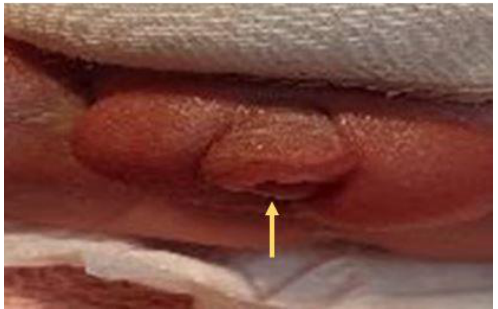
Figure 9. A second degree (proximal penis) hypospadias was noted with meatus (arrow) opening at the proximal shaft of penis. 2.4. Case 4 A 26-year-old female G1P0 pregnant at 27 + 3 gestational age was noted to have “tulip” signs over external genitalia resemblance a third degree hypospadias (Figure 10). Sagittal view after external provocation with jet of fanning urinary stream originated di- rectly from perineum was noted (Figure 11). Coarctation of aorta and pulmonary stenosis was also noted in this fetus. Normal karyotyping with 46XY was found.